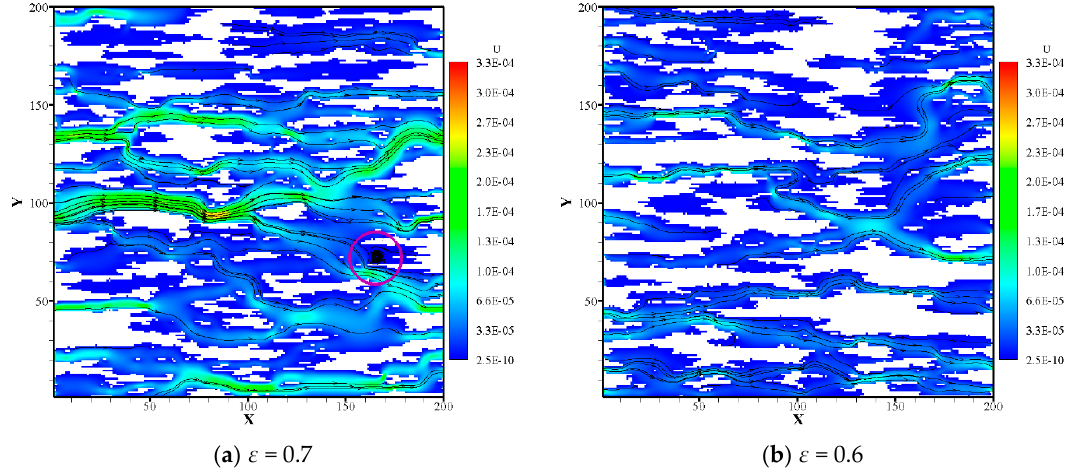
Figure 26. Flow field nephogram of quartet structure generation set with different porosity.